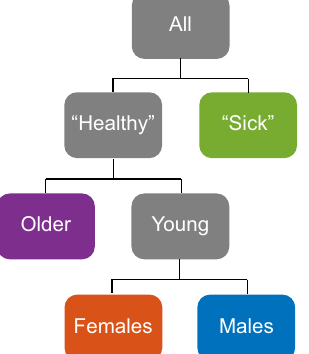
Fig. 5 The hierarchy of the principles that shape the spatial organization of the data-points. The fi rst PC is correlated to markers of disease state like LPIR, insulin, HOMA IR (diabetes), triglyceride, LDL, (Cardio-vascular disease), white cell count, neutrophils (in fl ammation). And therefore, the fi rst split of the data is according to wellness state. The second PC is correlated with omega 3 in different forms. High levels of omega 3 are achieved from supplement uptake, which characterize older individuals and therefore the second split is based on supplement uptake / or age. The third and 4 th PC ’ s are correlated with lipids and markers like: Hemoglobin, Hematocrit, Red cell count, that separate the males and females and therefore the last split is according to sex (Table